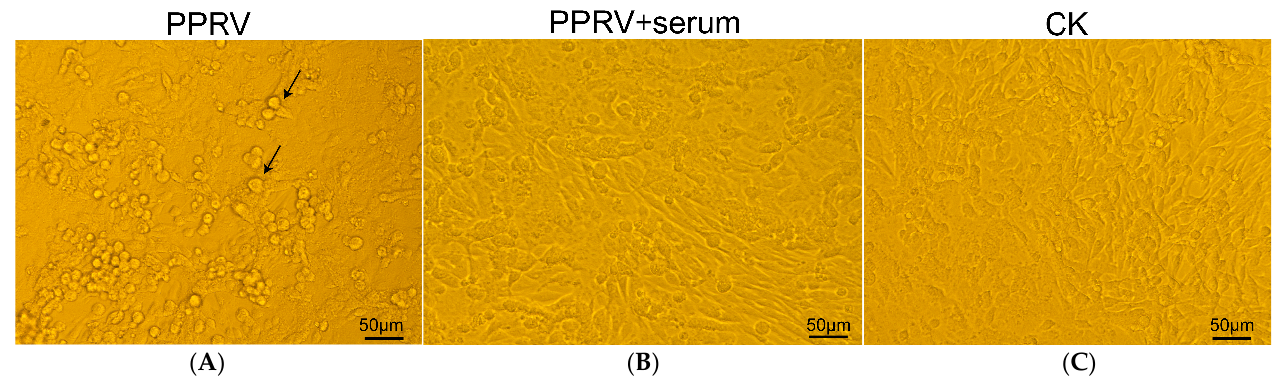
Figure 6. A schematic diagram of the cytopathic state in neutralization experiments. ( A ) PPRV virus control group; ( B ) Neutralizing antibodies completely inhibited PPRV; ( C ) CK. This study used 100 TCID 50 PPRV virus solution. The CPE was characterized by rounding of cells, their detachment from the surface and syncytia formation. The virus-treated group had significant syncytial lesions, and the treated cells had no syncytia after the virus was completely inhibited by the appropriate dilution concentration of serum. The arrow points to the syncytium in the figure. The scale bar is 50 μ m.